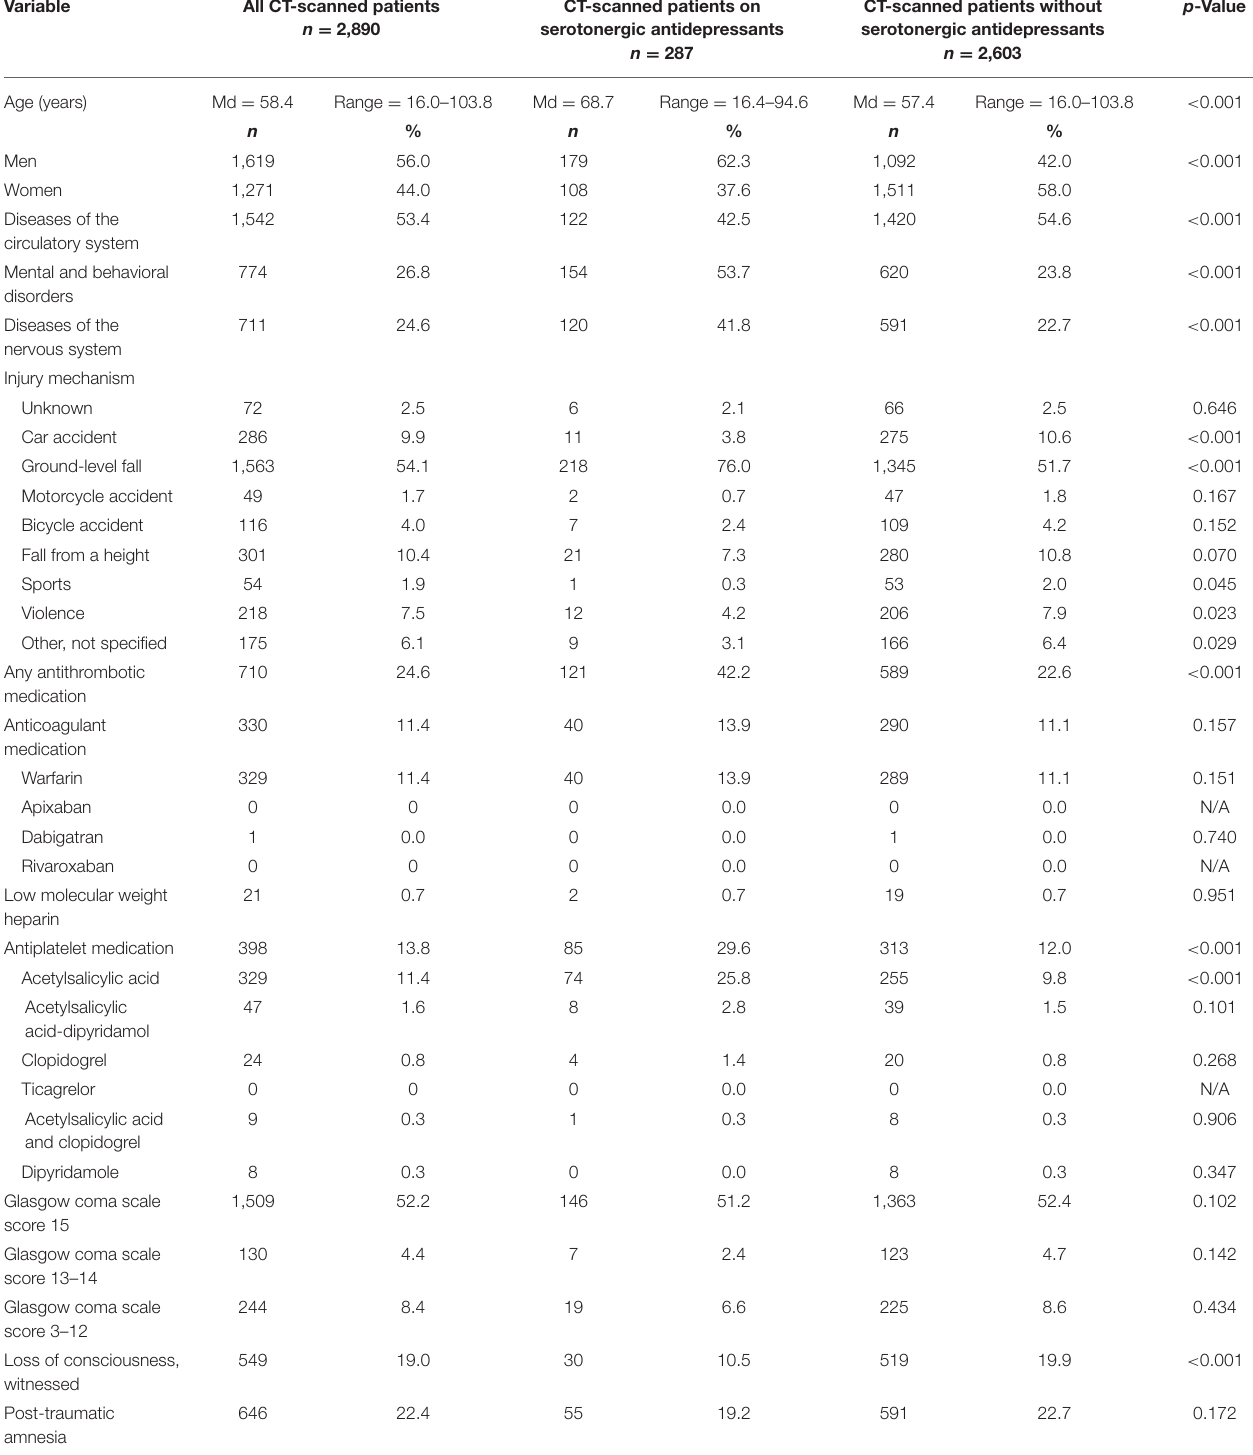
TABLE 1 | Characteristics of the study